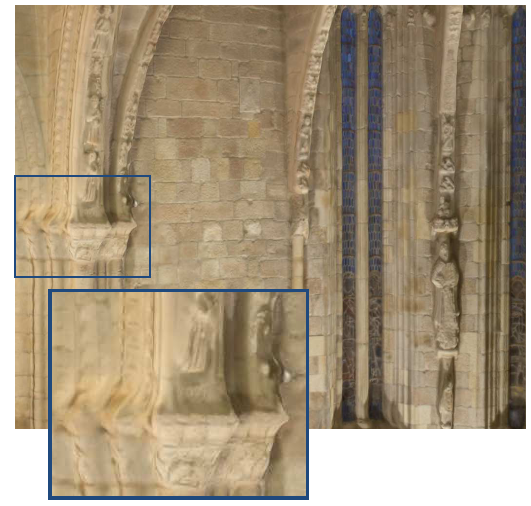
Figure 11. Areas do not fit to